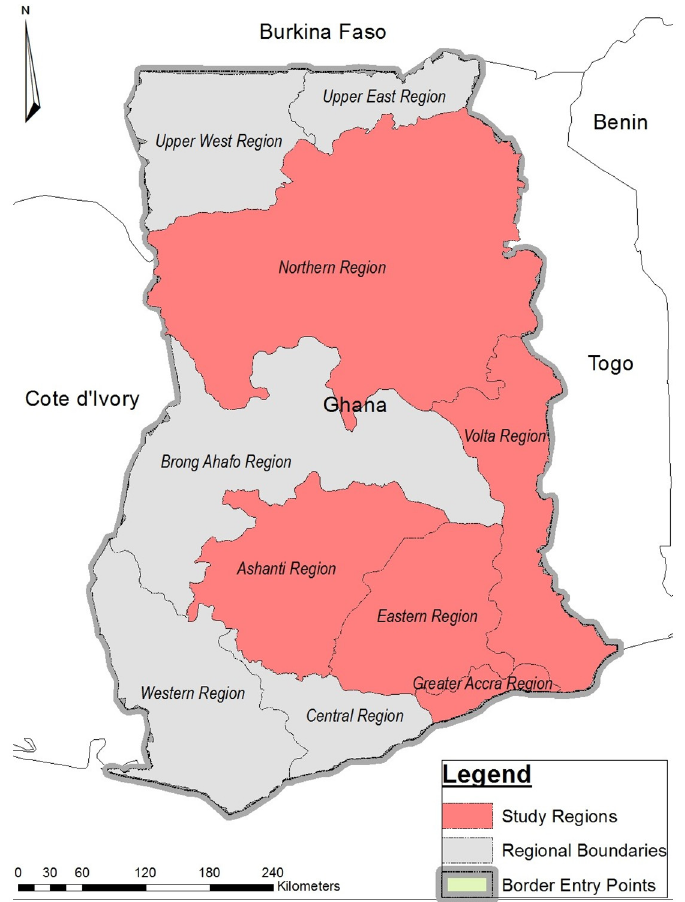
Fig 1. Map showing study areas and borders with neighbouring